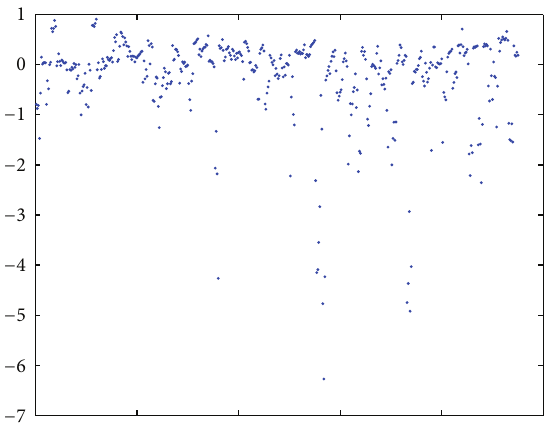
Figure 1: Distribution of working capital in the whole industry.